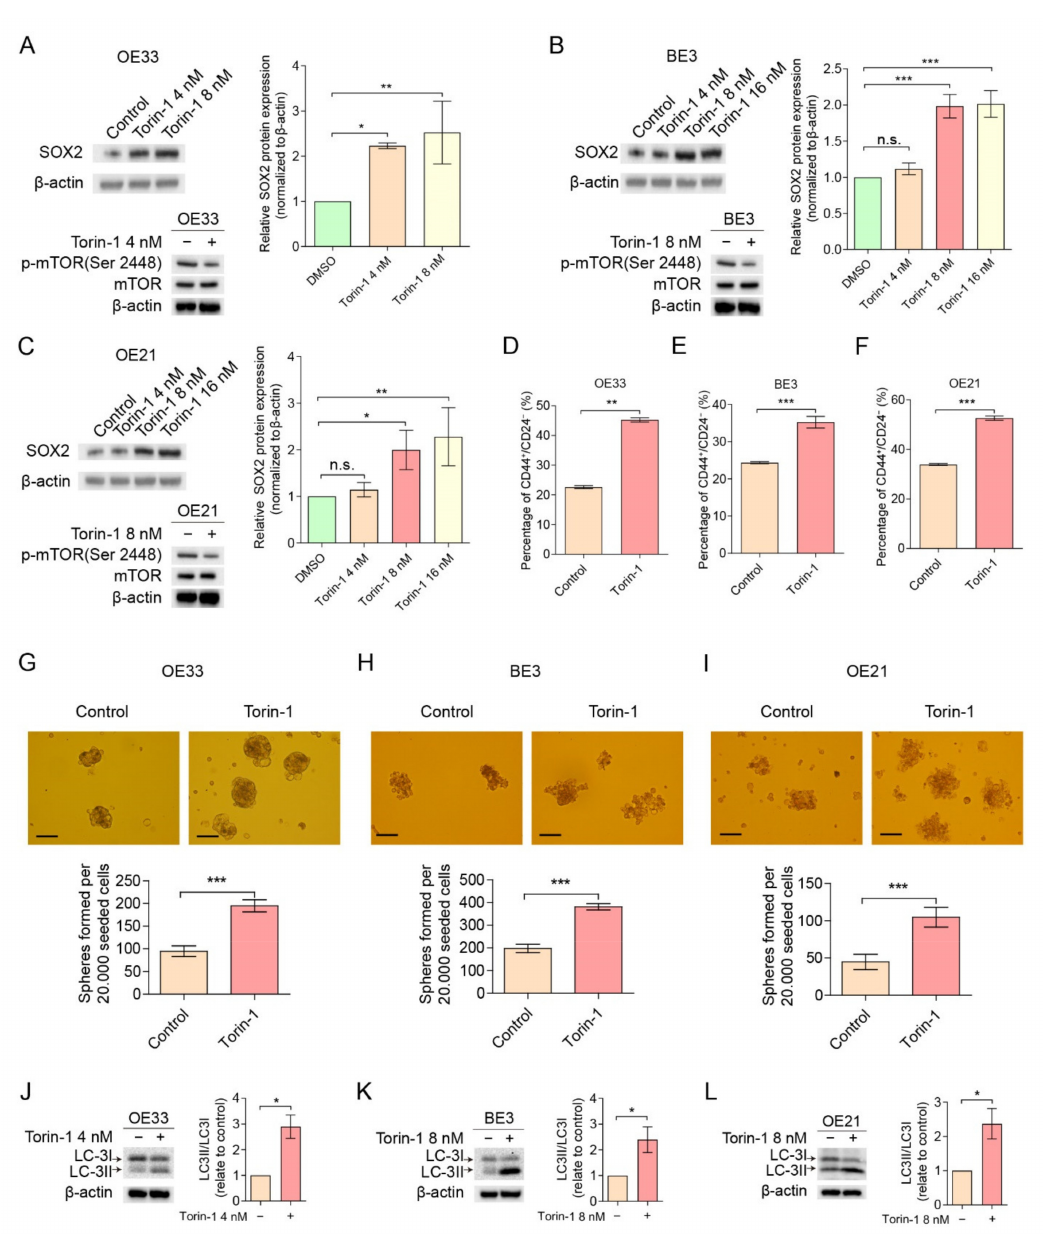
Figure 2. mTOR inhibitor Torin-1 up-regulates CD44 + /CD24 − CSC population, sphere formation and autophagy. ( A – C ) Cells treated with Torin-1 showed an increased expression of SOX2 compared to DMSO controls (OE33 at 4 nM, BE3 and OE21 at 8 nM and 16 nM). ( D – F ) Cells treated with Torin-1 (OE33 at 4 nM, BE3 and OE21 at 8 nM) for 48 h showed an up-regulation in the CD44 + /CD24 − CSC population compared to DMSO controls ( n = 3). ( G – I ) Cells treated with Torin-1 (OE33 at 4 nM, BE3 and OE21 at 8 nM) for 48 h elevated the sphere generation capacity compared to DMSO controls ( n = 3). Scale bar = 100 µ m. ( J – L ) Cells treated with Torin-1 (OE33 at 4 nM, BE3 and OE21 at 8 nM)